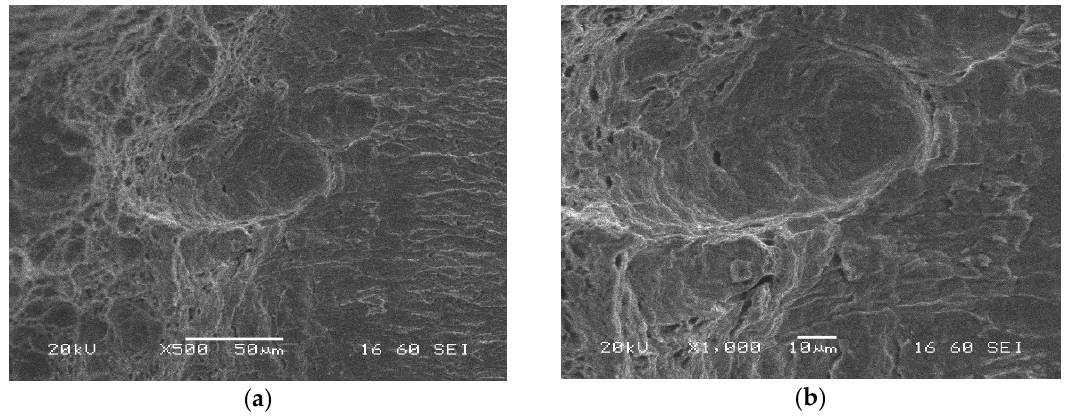
Figure 19. Microstructures of the transient (fatigue pre-crack and crack propagation) region of the HAZ (specimen No. 6) captured after CTOD test using SEM; magnifications: ( a ) ×500; ( b ) ×1000.